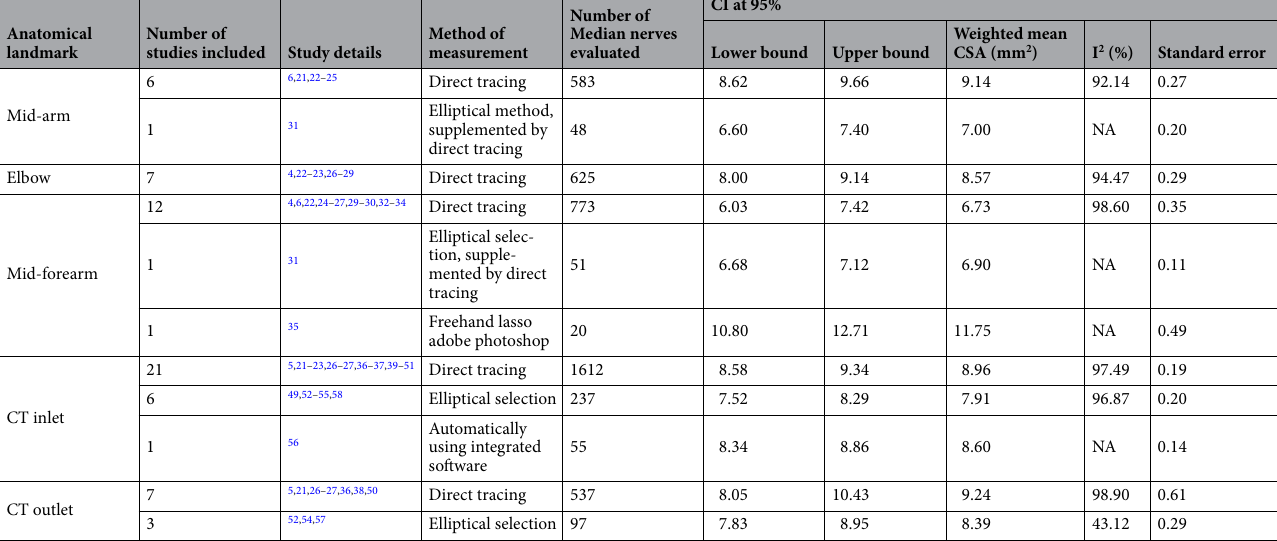
Table 5. Subgroup analysis of included studies (n = 41), stratified based on method of measuring CSA at different anatomical landmarks measuring median nerve. CSA = cross sectional area. CI = confidence intervals. NA indicates the inclusion of only one study for the analysis, hence heterogenicity (I 2 ) cannot be